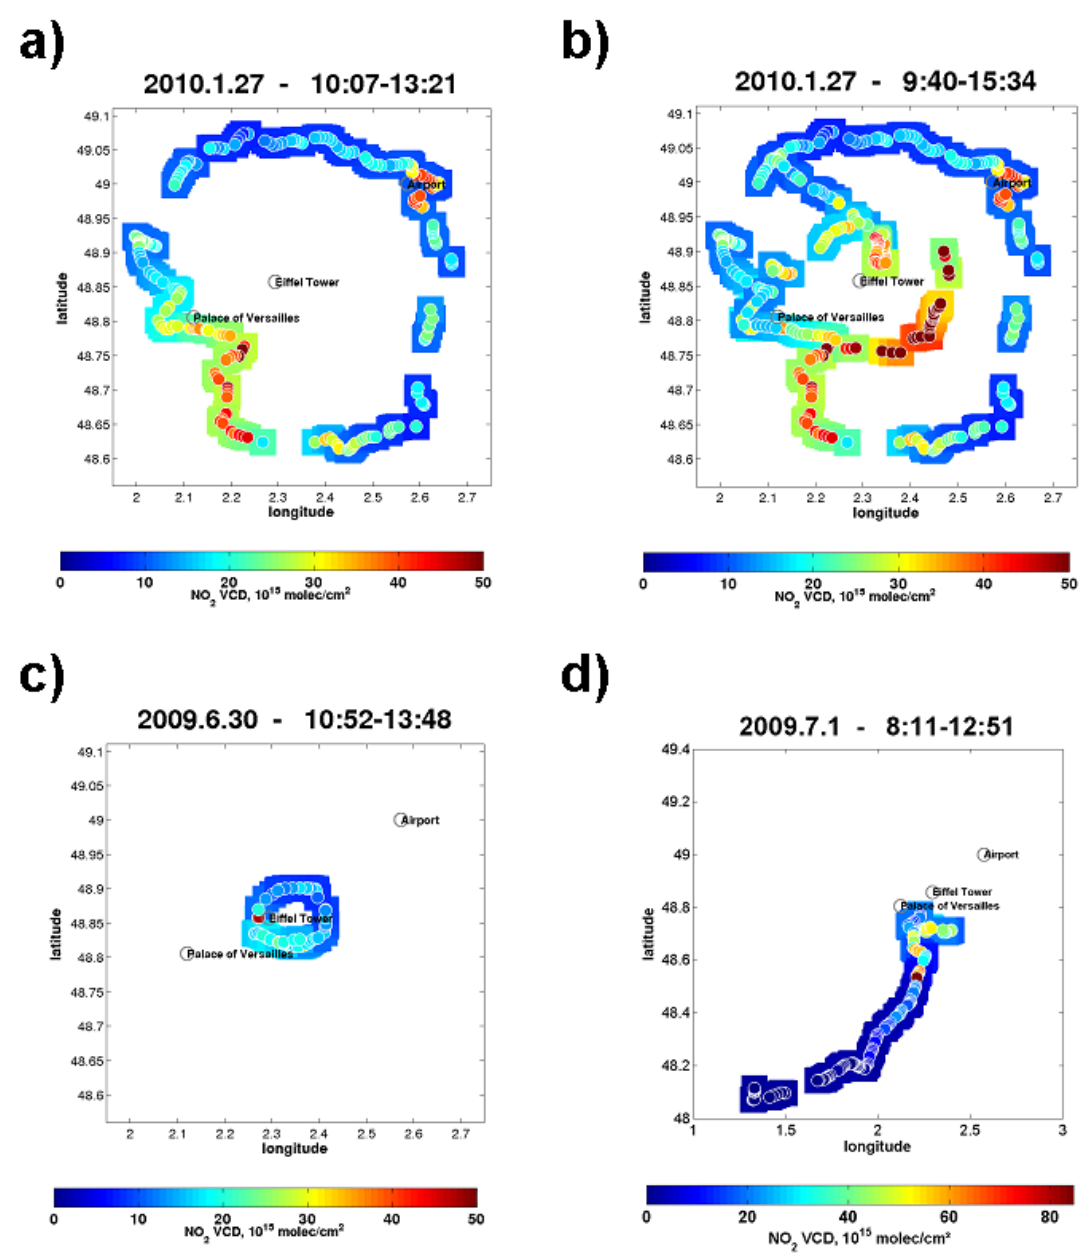
Figure 2. Typical car-MAX-DOAS results. (a) Measurements around large circles; (b) measurements around large circles and in the city centre; (c) measurements around small circles; (d) measurements at other road